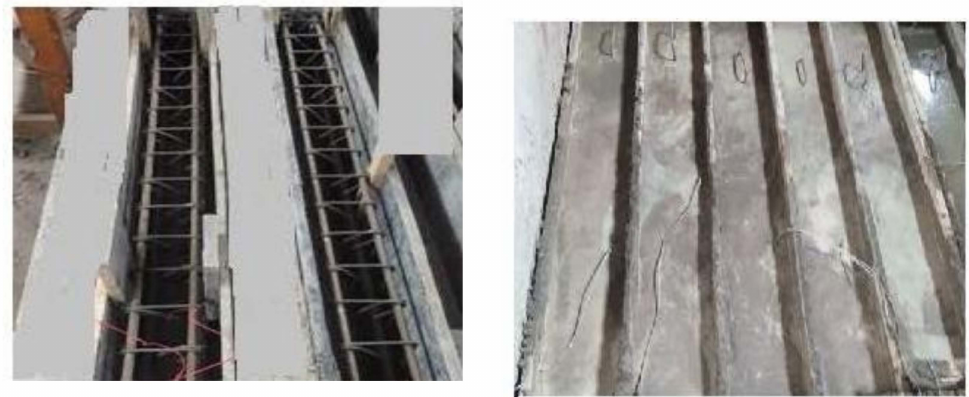
Figure 3. Reinforcement details and casting of some studied